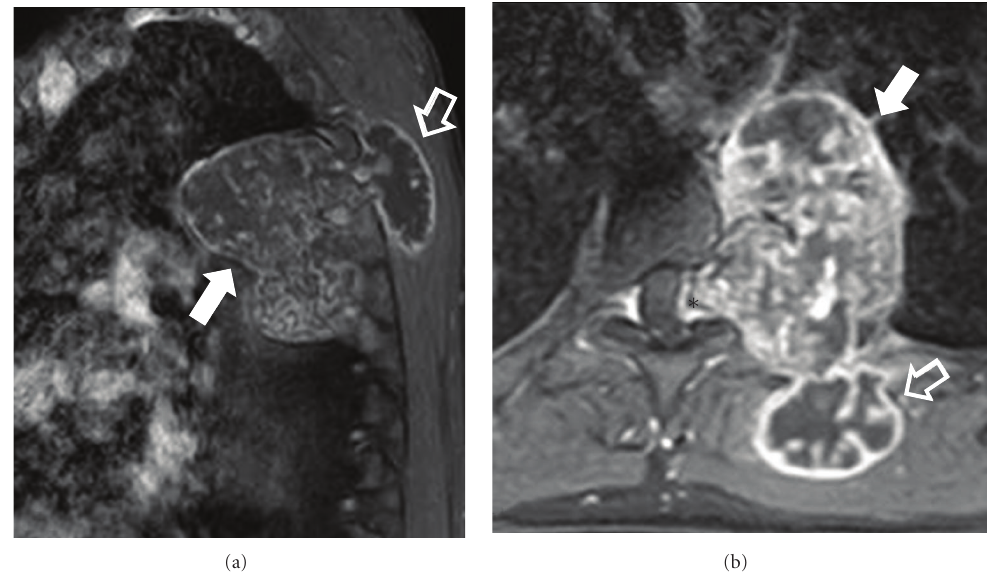
Figure 4: MR imaging of the same patient. The sagittal (a) and axial (b) contrast-enhanced fat-saturated T1-w MR images show intense heterogeneous enhancement of both the intrathoracic (arrows) and the superficial (open arrows) tumor components. Enhancement is also observed in the intraforaminal component of the tumor